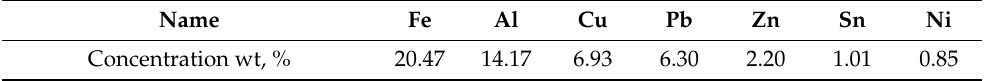
Table 2. The typical composition of basic metals in PCBs, based on available online references [1].